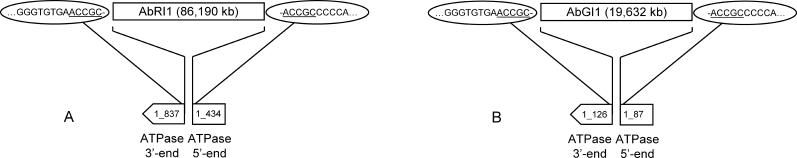
Comparison of Insertion Sites of the AbaR1 and AbaG1 Islands in an ATPase ORFInsertion sites of the AbaR1 (A) and AbaG1 (B) islands in an interrupted ATPase-encoding ORF are compared. ORFs 1_837 and 1_434 in strain AYE, and 1_126 and 1_87 in strain SDF, retain a strong similarity to the 3′ and 5′ fragments, respectively, of the ATPase sequence encoded by Acinetobacter strain ADP1 [32]. The 5-bp direct repeats flanking the islands are underlined.